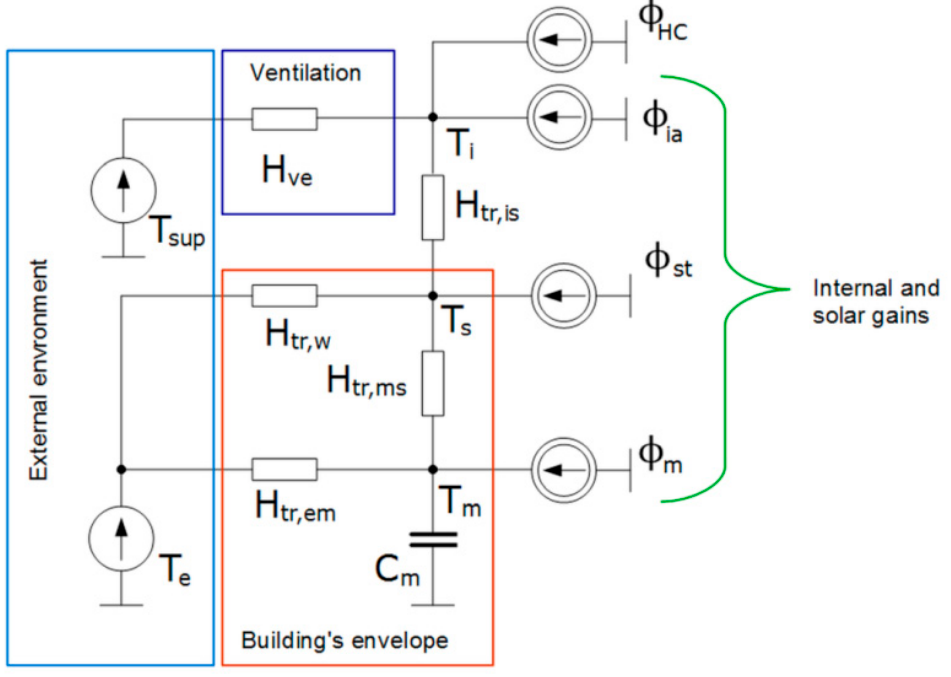
Figure 1. The 5R1C thermal network model of a building zone from EN ISO 13790.